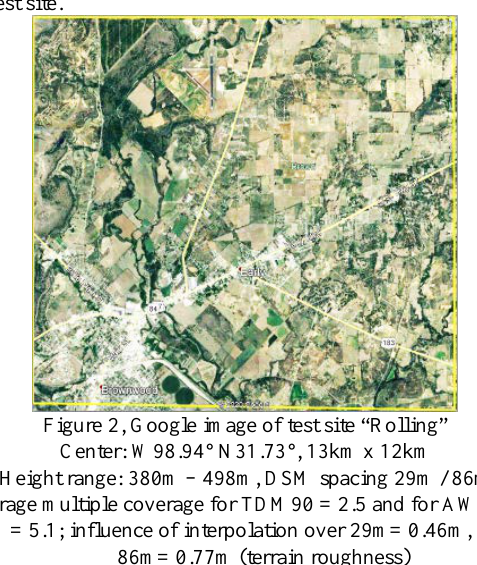
Figure 2, Google image of test site “Rolling” Center: W98.94° N31.73°, 13km x 12km